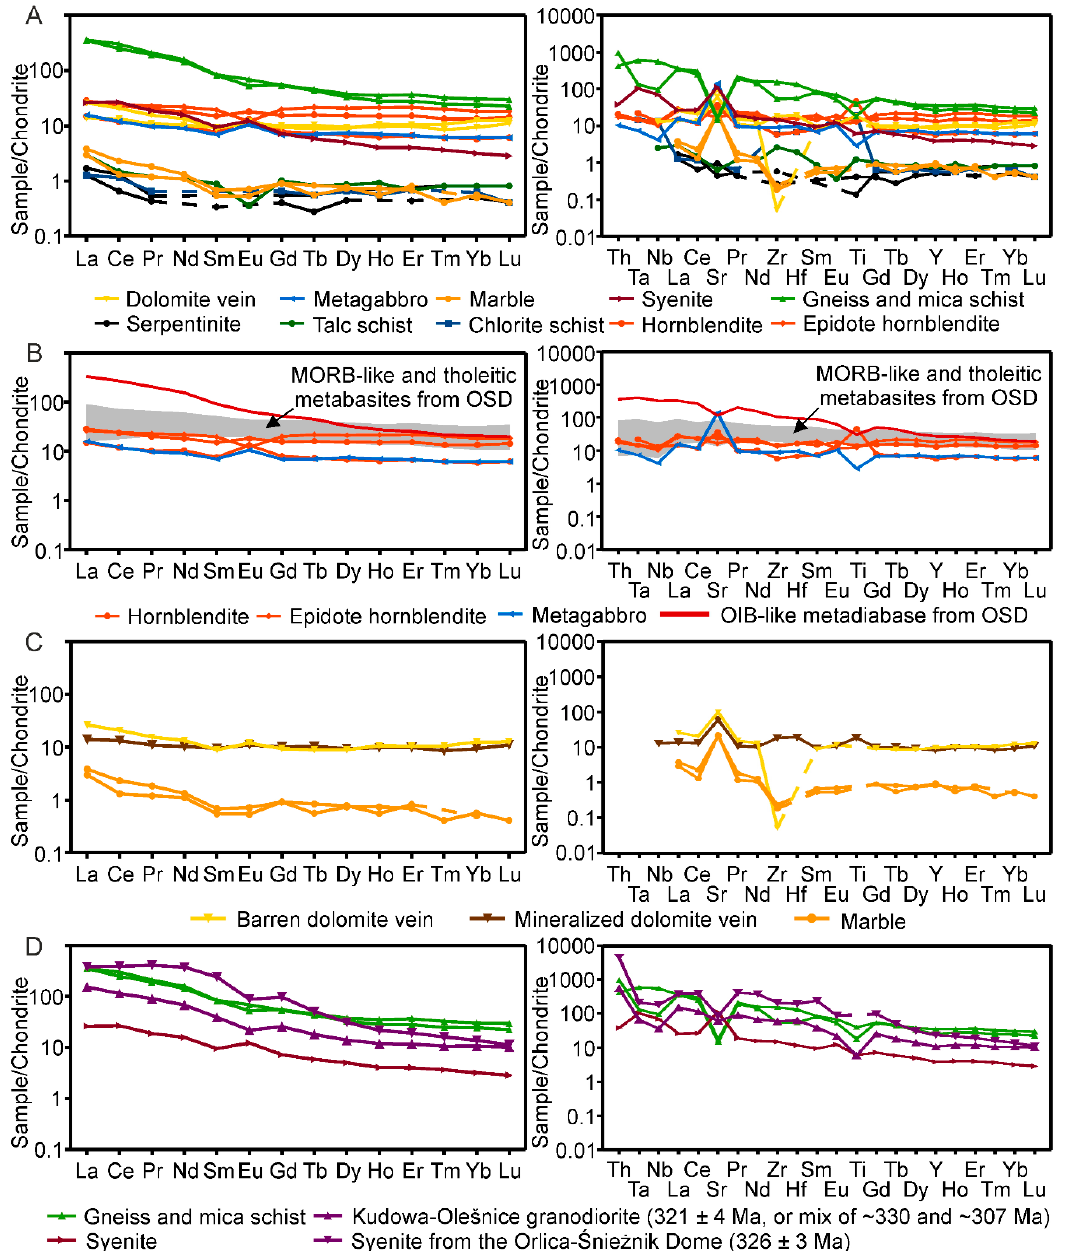
Figure 9. The chondrite-normalized rare earth elements (REE; left hand) and selected trace elements (right hand) patterns of rocks from the Kletno deposit and comparable samples. ( A ) Serpentinite, talc schist, chlorite schist, hornblendites, dolomite veins (without subdivision into barren and mineralization-bearing veins), barren metagabbro, marble, country non-carbonate metasediments (jointly paragneiss and mica schist), and syenite vein hosted in paragneiss; ( B ) Metagabbro and hornblendites plotted against various MORB-like and tholeitic metadiabases and pillow metabasalts, and OIB-like metadiabase from the western limb of the OSD [21]; ( C ) Dolomite veins (subdivided into the barren dolomite vein and mineralization-bearing vein) plotted against country marble; ( D ) Country paragneiss and mica schist plotted against syenite vein hosted in paragneiss, as well as post-tectonic syenite vein from the western limb of the OSD [41] and granodiorite of the Kudowa-Olešnice massif [35].